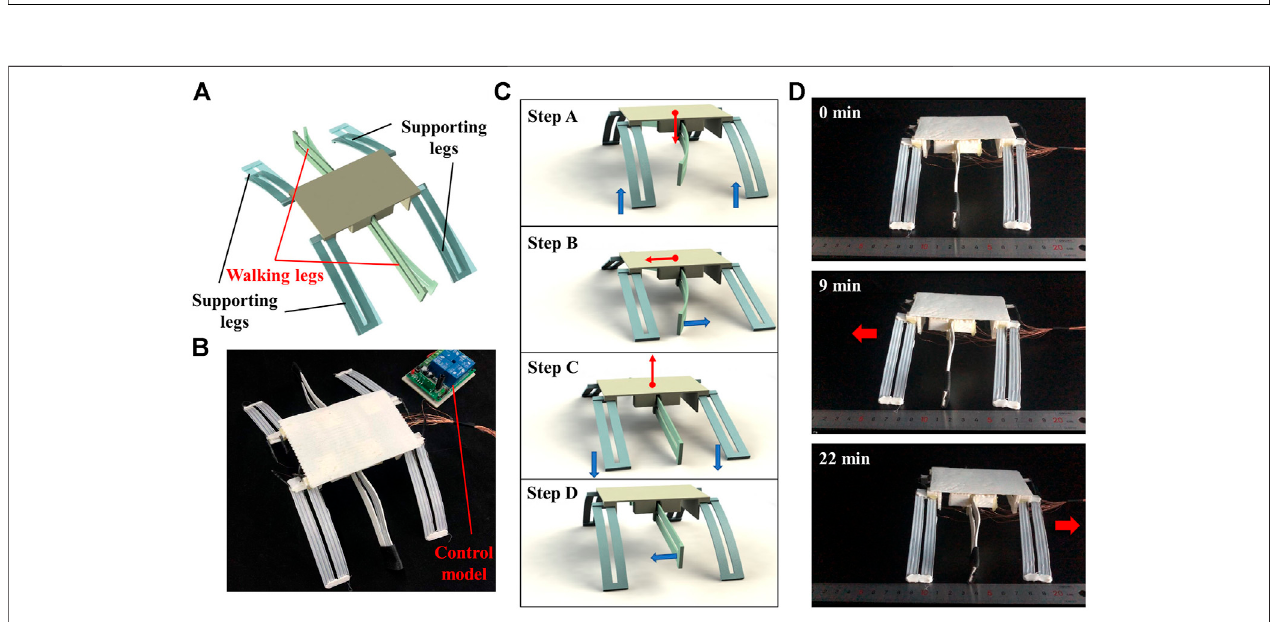
FIGURE 7 | Demonstration of walking robot. (A) Design model. (B) Photograph of walking robot. (C) Four steps in a gait cycle of walking robot. (D) Forward and backward motion of walking robot.